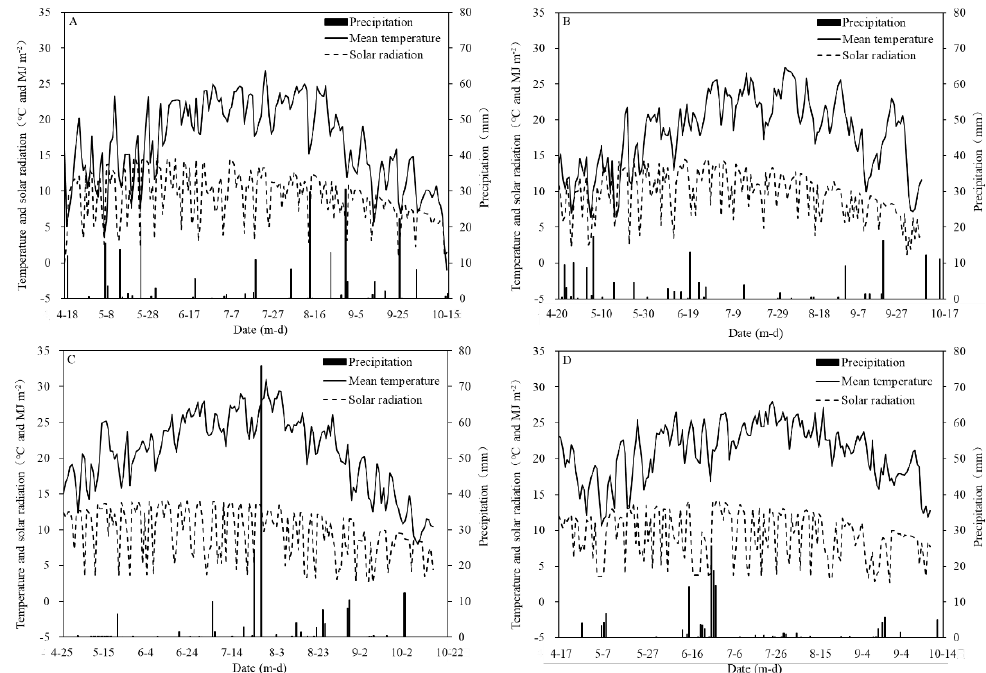
Figure 2. Weather data of the site from 2018 to 2019. ( A ) 2018 Qitai, ( B ) 2019 Qitai, ( C ) 2018 Yinchuan, ( D ) 2019 Yinchuan.